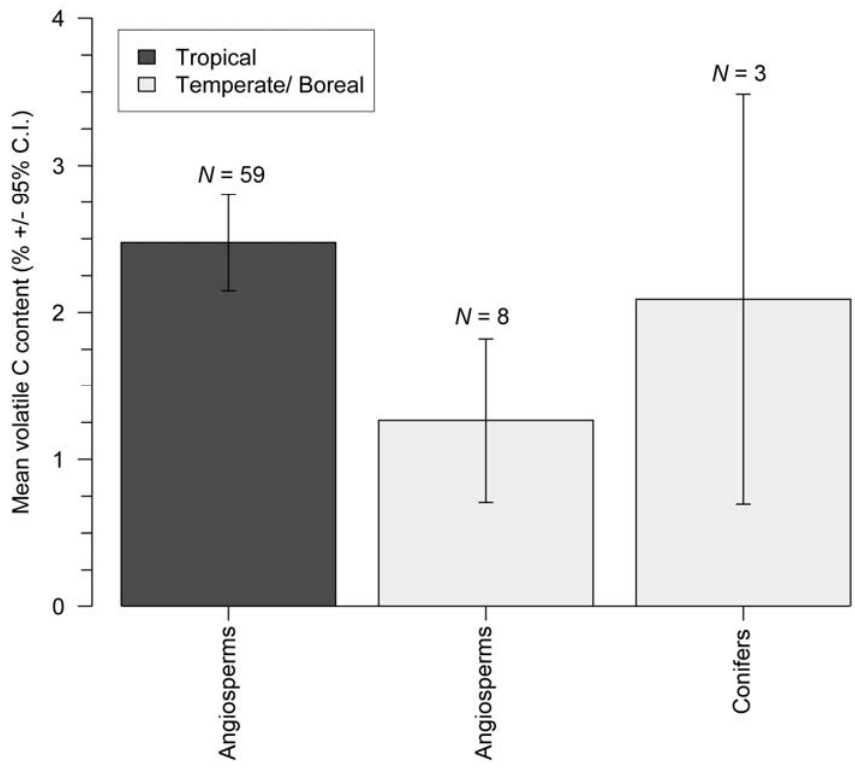
Figure 3. Comparisons of the volatile C fraction [ sensu 1,3] across two biomes (tropical, temperate/boreal) and two tree types (angiosperms, conifers). Height of each bar represents the mean C estimated as least squares means for each grouping, and error bars represent vol 95% confidence intervals (Table 2). Sample sizes ( N species) for each grouping are represented above each